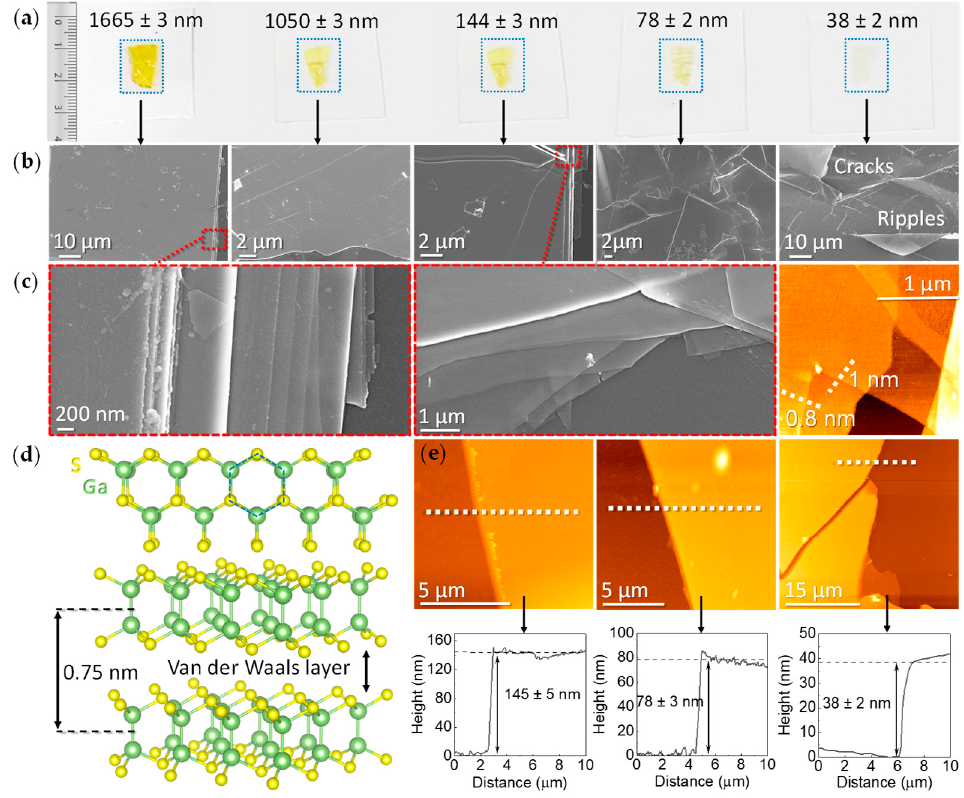
Figure 1. ( a ) Picture of exfoliated GaS of various thicknesses transferred onto glass. ( b ) Corresponding SEM images of the exfoliated GaS samples in ( a ) as a function of thickness. ( c ) Details from SEM and AFM images of the edges of samples to show the GaS layered structure. ( d ) Top view and side view of the GaS crystal structure, showing the monolayer composed of S–Ga–Ga–S bonds and the Van der Waals interaction between layers; the thickness of 0.75 nm for a monolayer is also shown. ( e ) AFM images and line profiles for the 144, 78, and 38 nm samples, from which average thickness has been determined.